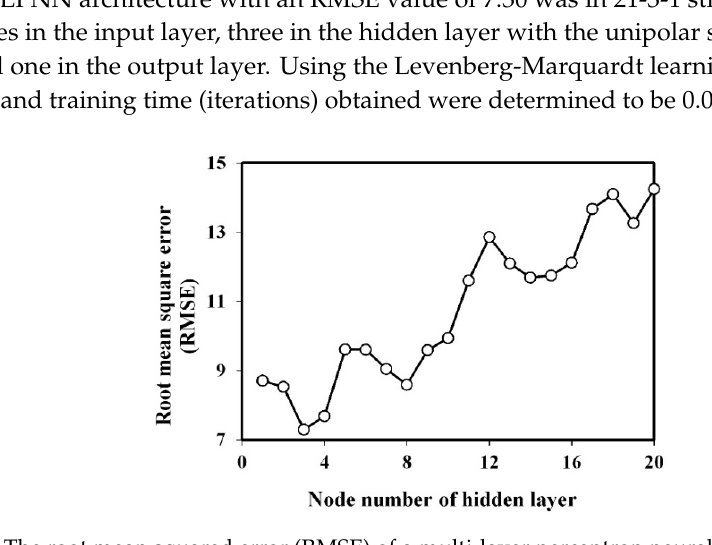
Table 3. Descriptive statistics values of SOC and bulk density (BD) at the sampling sites.